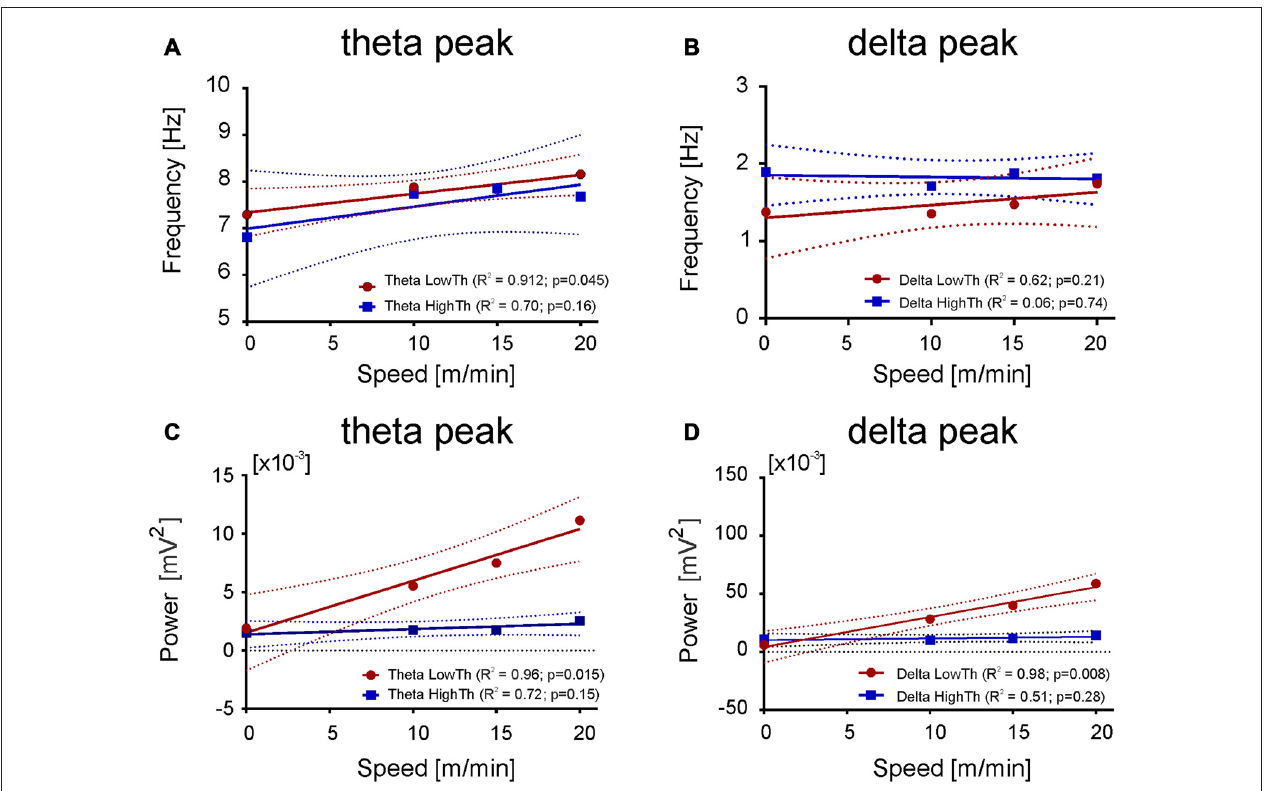
FIGURE 7 | Relationship between the frequency and power of maximum in the delta and theta band and the speed. (A,C) Both frequency and power of theta peak increase with the speed of an animal for LFPs recorded from the LowTh sites, while for the HighTh sites the relationship was not significant. (B,D) Opposite to that the frequency of delta peak was not related with the speed of rat both for LowTh and HighTh sites. Note that in contrast to the theta peak, in the delta peak only the power was related to the speed of locomotion of the animals of LowTh group